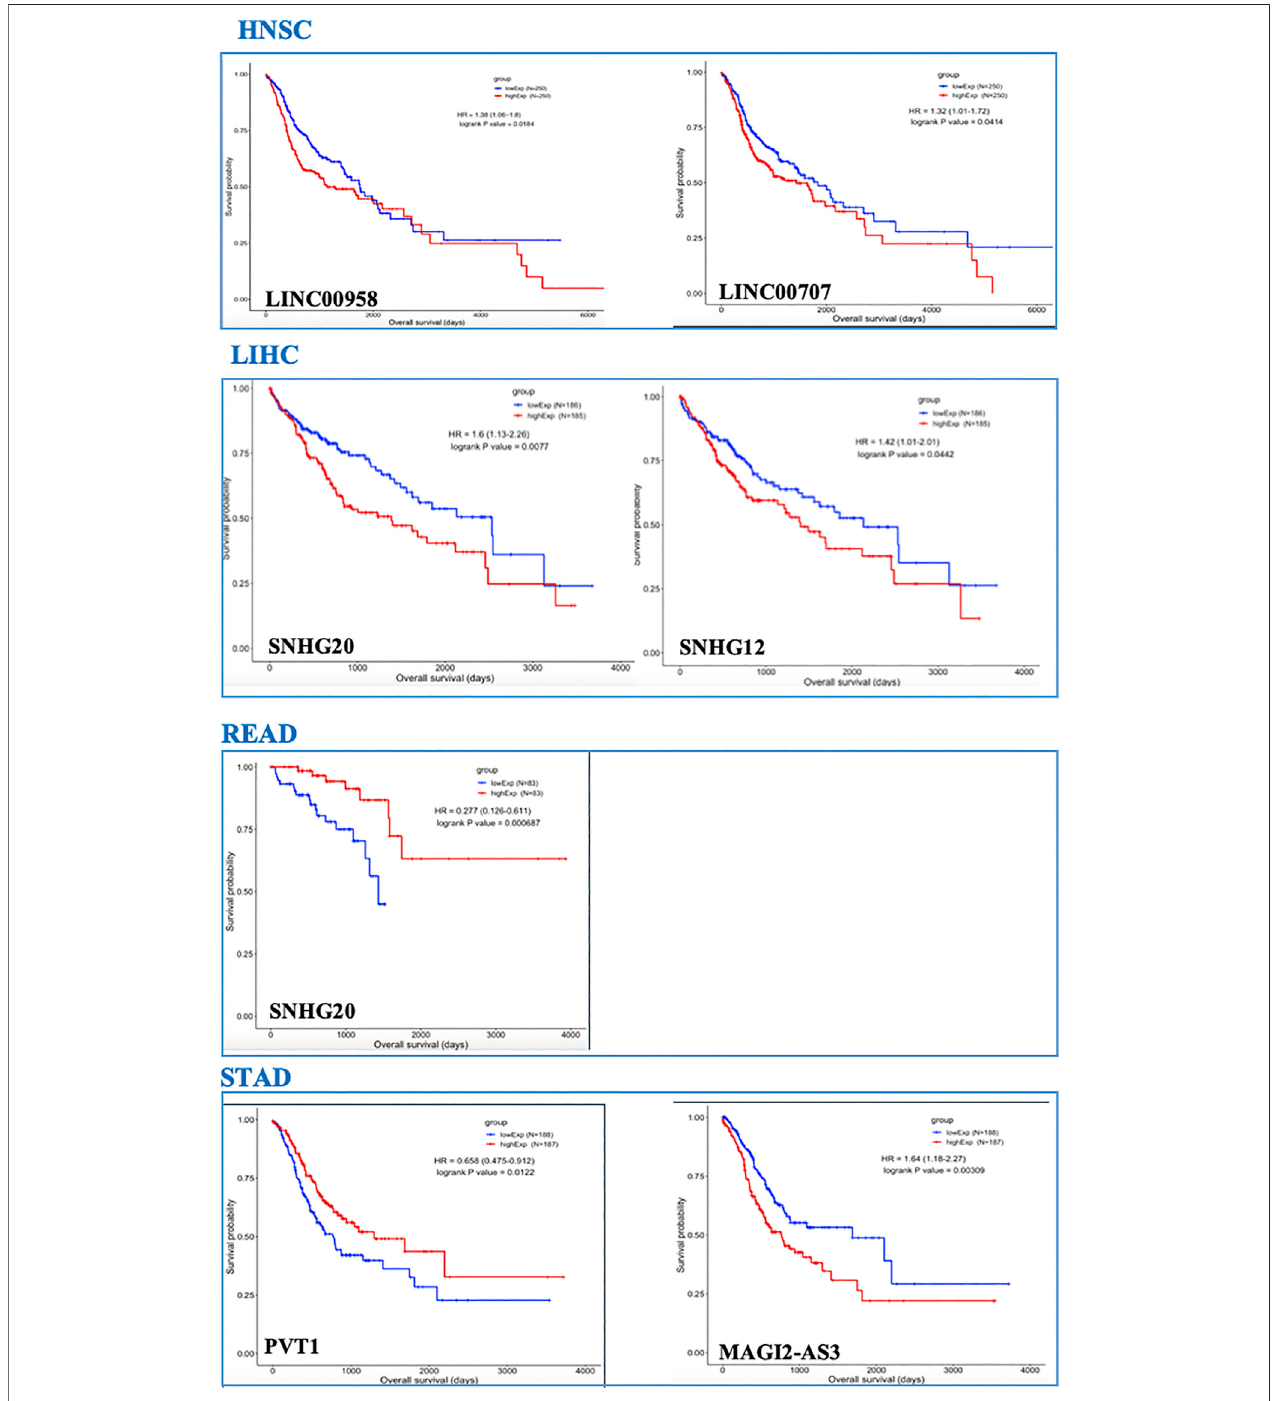
FIGURE 2 | OS analysis for lncRNAs in TCGA-GI cancers. Only lncRNAs with prognostic values are shown.